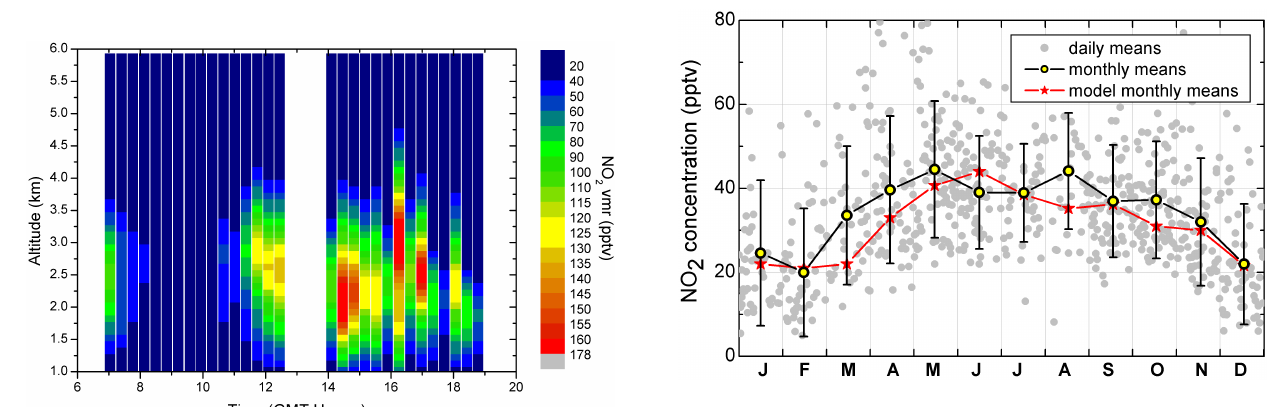
Figure 6. NO 2 concentration monthly means at the level of Izaña observatory with their respective standard deviations (open circles and black lines). CAM-Chem model results for the same level are shown for comparison (red stars and lines). Individual solid gray circles represent the 3-year diurnal